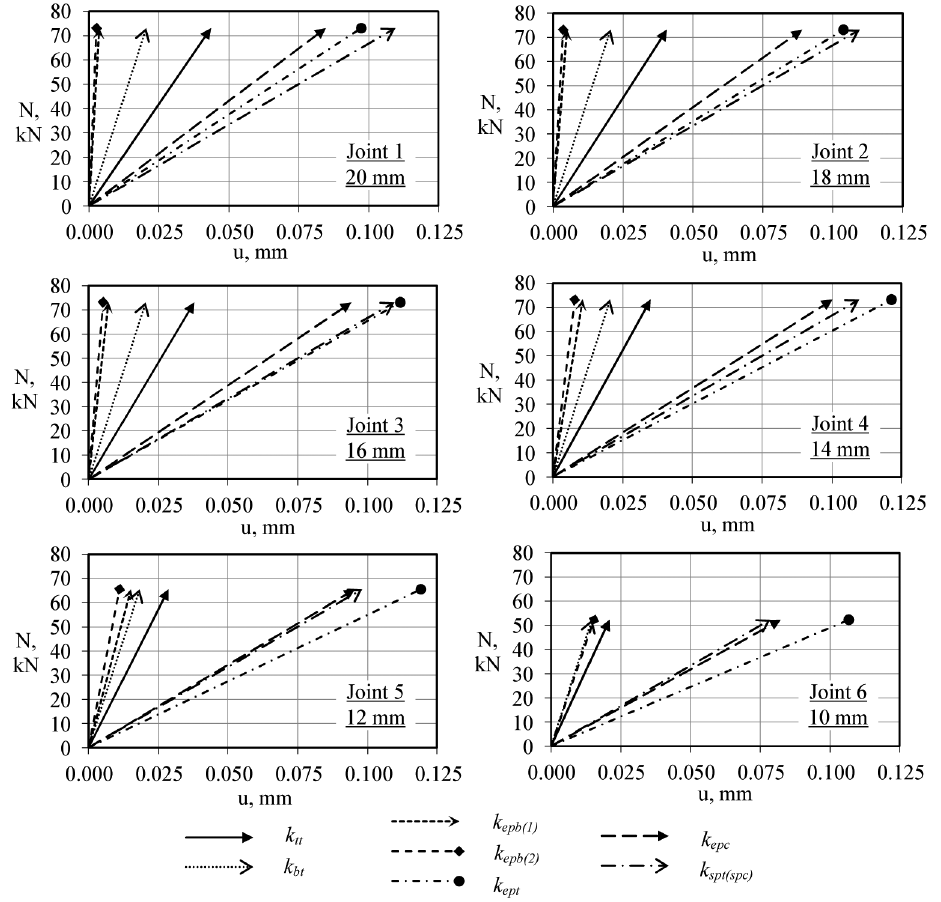
Fig. 11. Load-deformation curves of components for joints 1, 2, 3, 4, 5 and